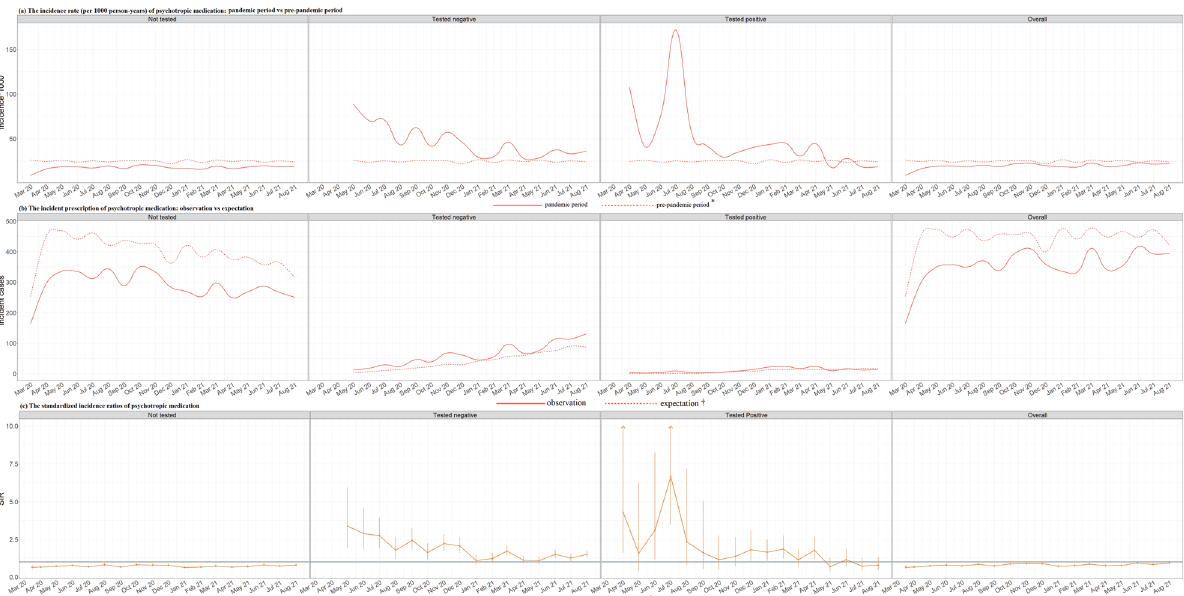
Fig. 3 Period speci fi c incident prescription of anxiolytics and antidepressants. Note, IR incidence rate, SIR standardized incidence ratio. * Three preceding years as the pre-pandemic period (i.e., from 1 January 2017 to 31 December 2019). † The expectation was calculated by multiplying the number of persons by the average month-speci fi c, sex-speci fi c, and age-speci fi c (1-year strata) incidence rate derived from pre-pandemic period. ‡ The standardized incidence ratio was calculated by comparing the number of observed incident cases with the